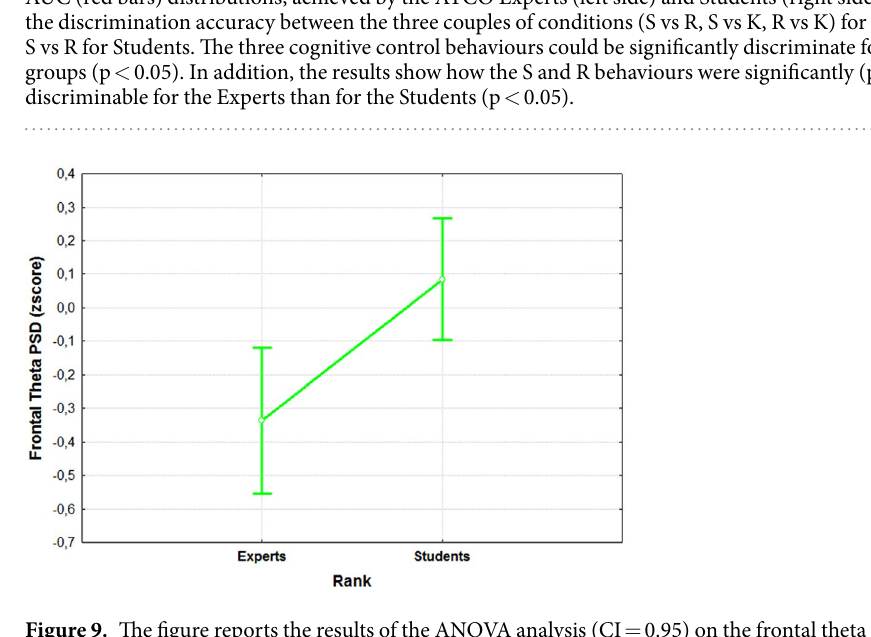
Figure 9. The figure reports the results of the ANOVA analysis (CI = 0.95) on the frontal theta PSD with the factor “RANK” of 2 levels (Experts and Students). The results showed that the two groups were statistically different (p = 0.005) in terms of activation of the frontal theta rhythm when facing the same SRK events.